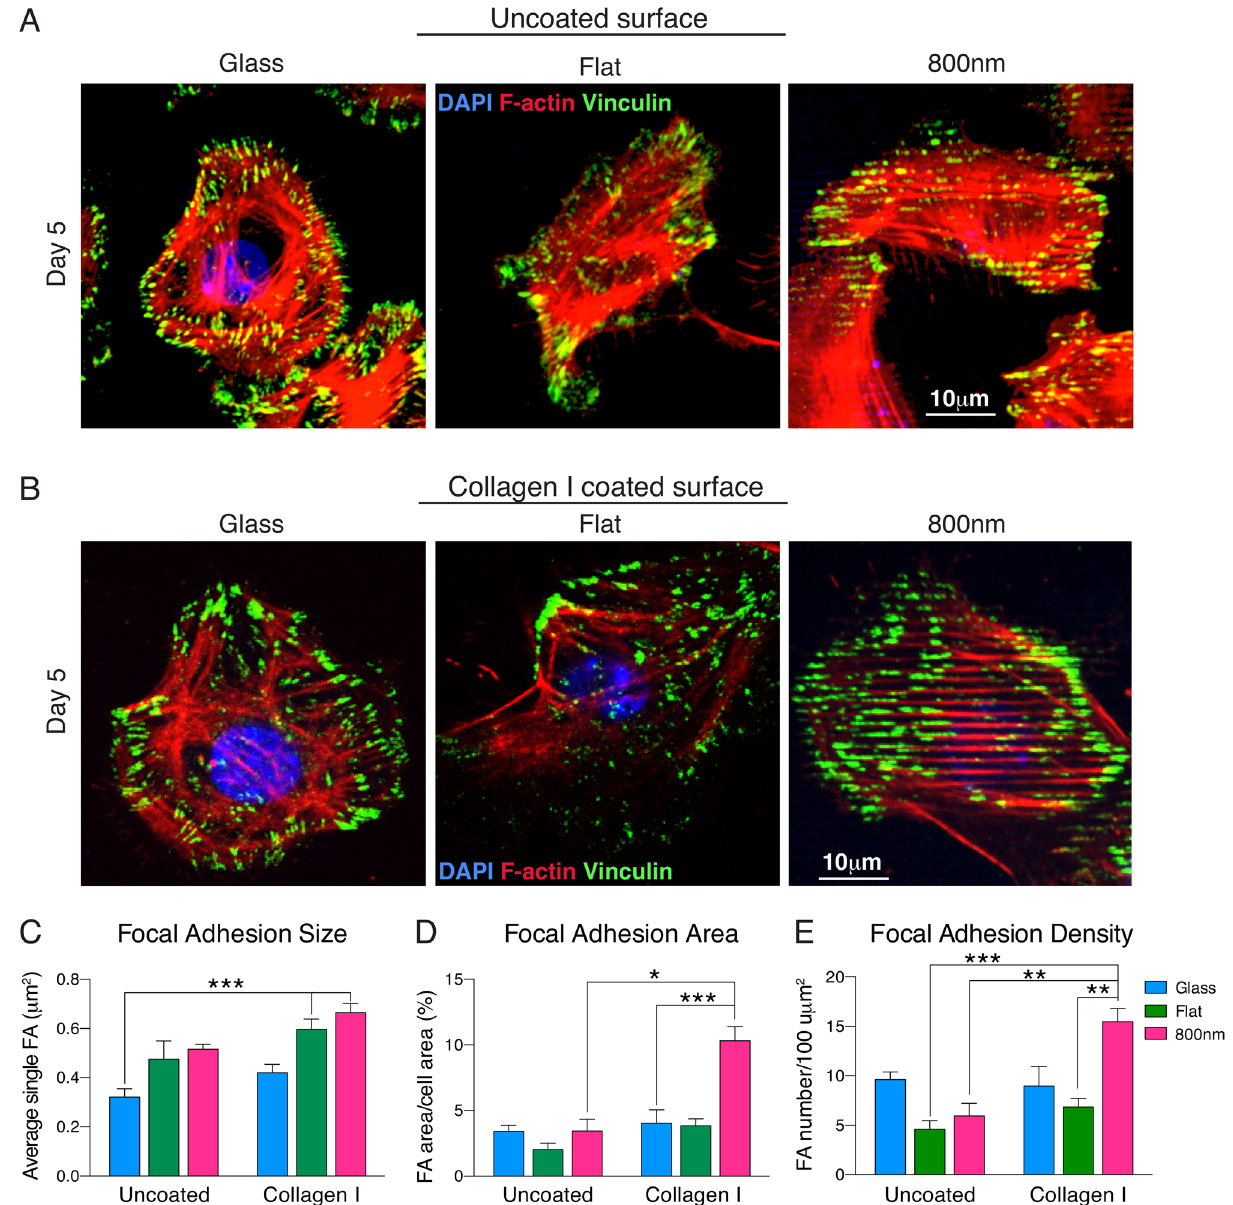
Figure 4. Smaller topography combined with collagen I coating induced higher cellular FA. MCEC were seeded on uncoated ( A ) or collagen I coated ( B ) glass, flat, or 800 nm silk films. After 5 days in culture, cells were stained for nuclei (blue-DAPI), vinculin (green- Oregon Green 488) and actin (red- Alexa Fluor 568) expression. Each vinculin punctate areas were analyzed to determine the FA size, FA area and density. ( C ) Individual FA size was defined by discrete areas of vinculin measurements and it was significantly larger on silk surfaces and addition of collagen I increased the cell FA size on each substrate. ( D ) The effect of collagen I was significantly evident when vinculin FA area was calculated, no major differences were observed on uncoated surfaces, but its addition to the 800 nm patterned silk films greatly increased the vinculin image area. ( E ) FA density was higher in cell cultured on glass across all uncoated substrate. However, addition of collagen I changed the vinculin density, especially on the 800 nm topography (* indicates p < 0.05, ** indicates p < 0.005, ***indicates p < 0.0005. Values are means ±